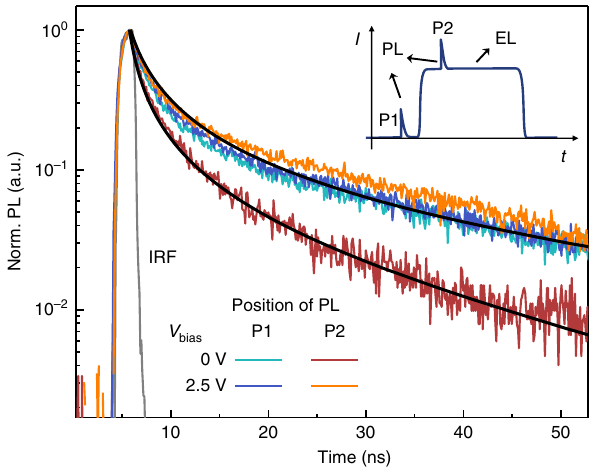
Fig. 3 Transient photoluminescence during voltage pulses. Transient photoluminescence decays acquired from an optical pump pulse ( λ = 355 nm, 20 ps pulse width, 0.2 µ J cm − 2 fl uence) incident 1 μ s before (P1) and after (P2) the start of a 0.05 A cm − 2 electrical pulse with different background bias levels as depicted in the inset diagram. Solid black lines are fi ts to the ABC rate equation described in the text. The instrument response function (IRF) is depicted by the gray line with a temporal resolution of 0.5